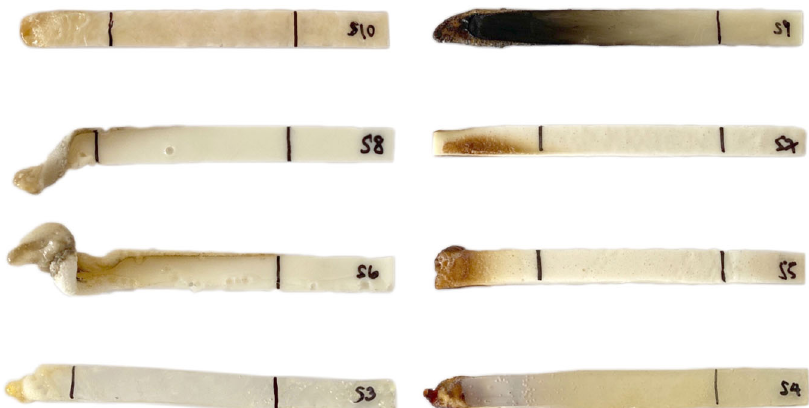
Fig. 5 Flammability property of coating samples. Left : AR3 series with aromatic diamine only. Right : AR4 series with both aromatic diamine and aromatic diisocyanate after fl ammability test.